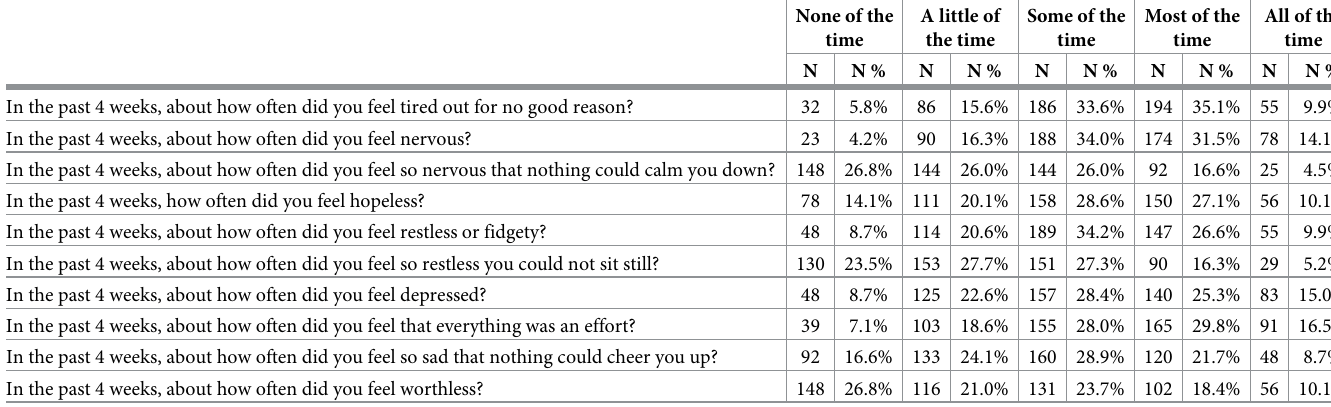
Table 4. Responses of participants to the (K10) scale questions.